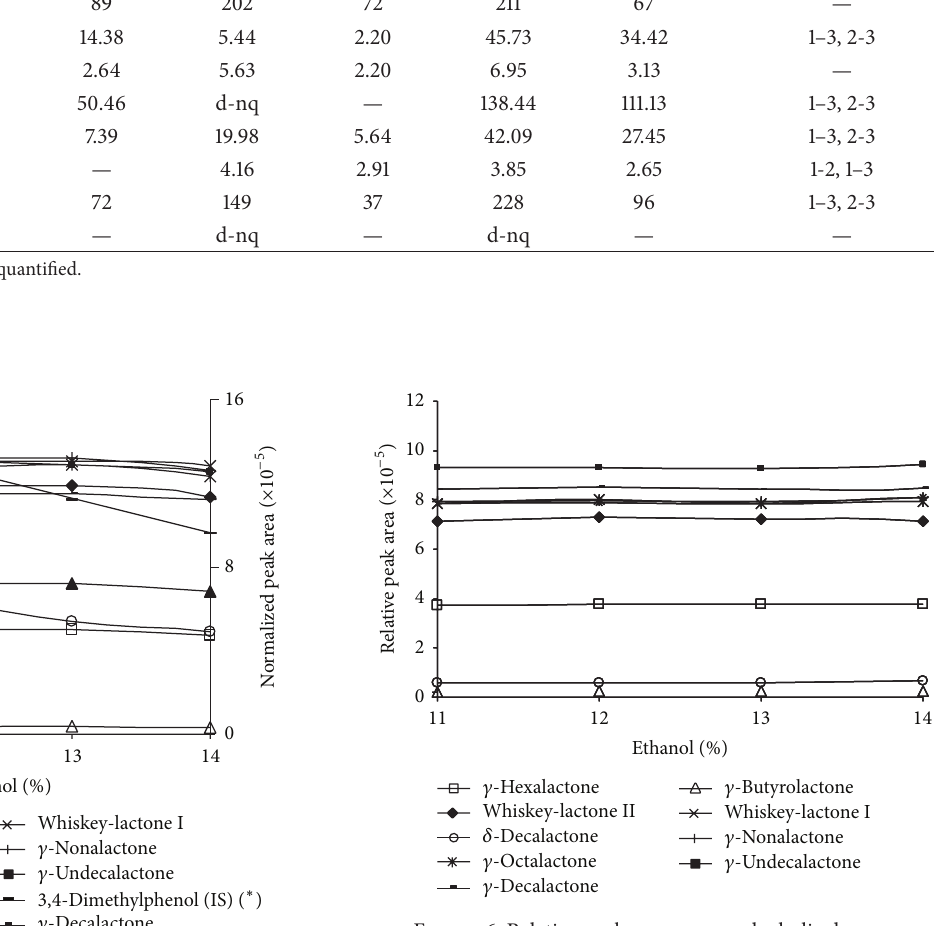
Figure 6: Relative peak areas versus alcoholic